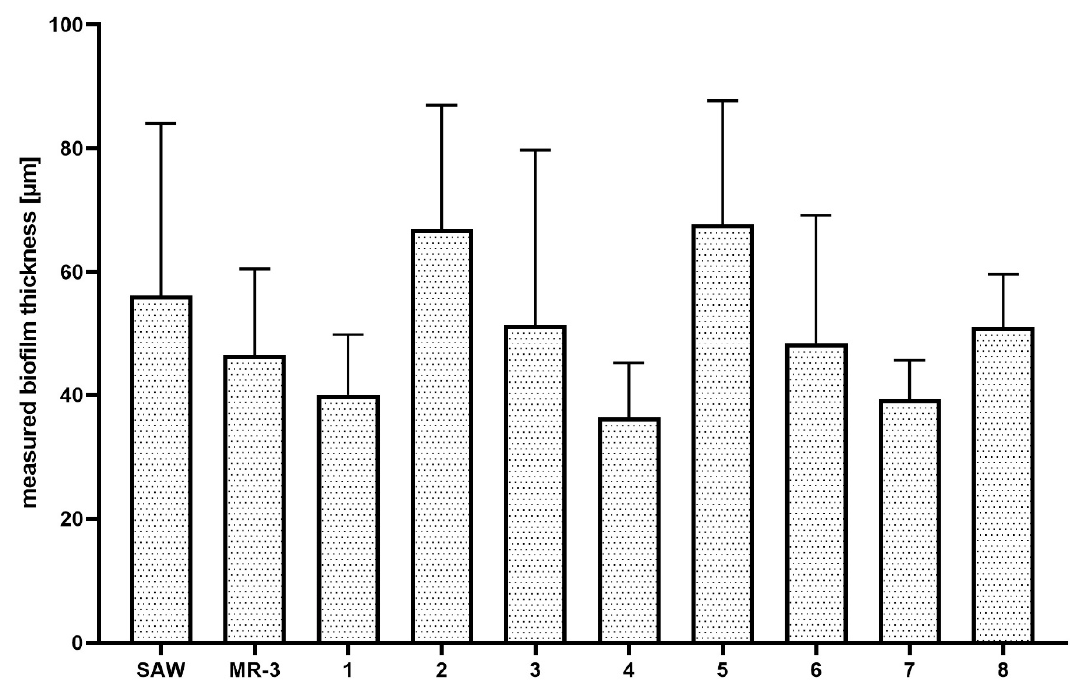
Figure 5. Measured thickness of staphylococcal biofilms ( n = 10) in vitro.